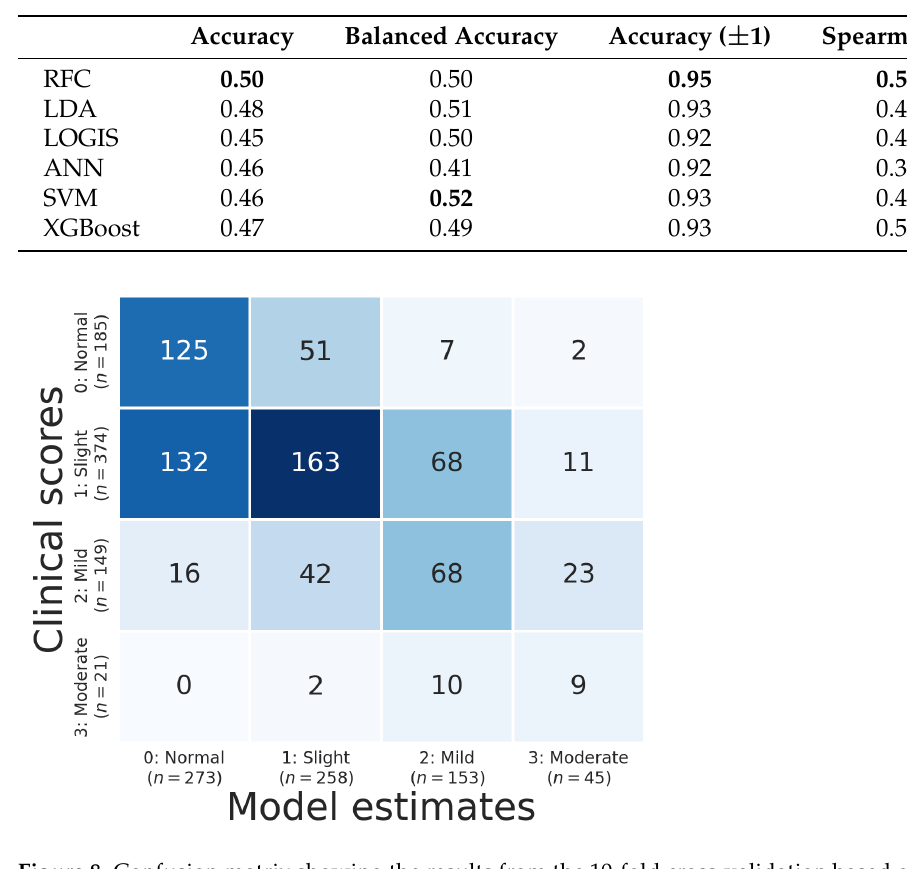
Table 4. Summary of classification metrics for the six types of models. RFC, Random Forest Classifier; LDA, Linear Discriminant Analysis; LOGIS, Logistic Regression; ANN, Artificial Neural Network; SVM, Support Vector Machine; XGBoost, Gradient Boosted Trees. The RFC was picked as it gave the best performance on three of the four classification metrics.